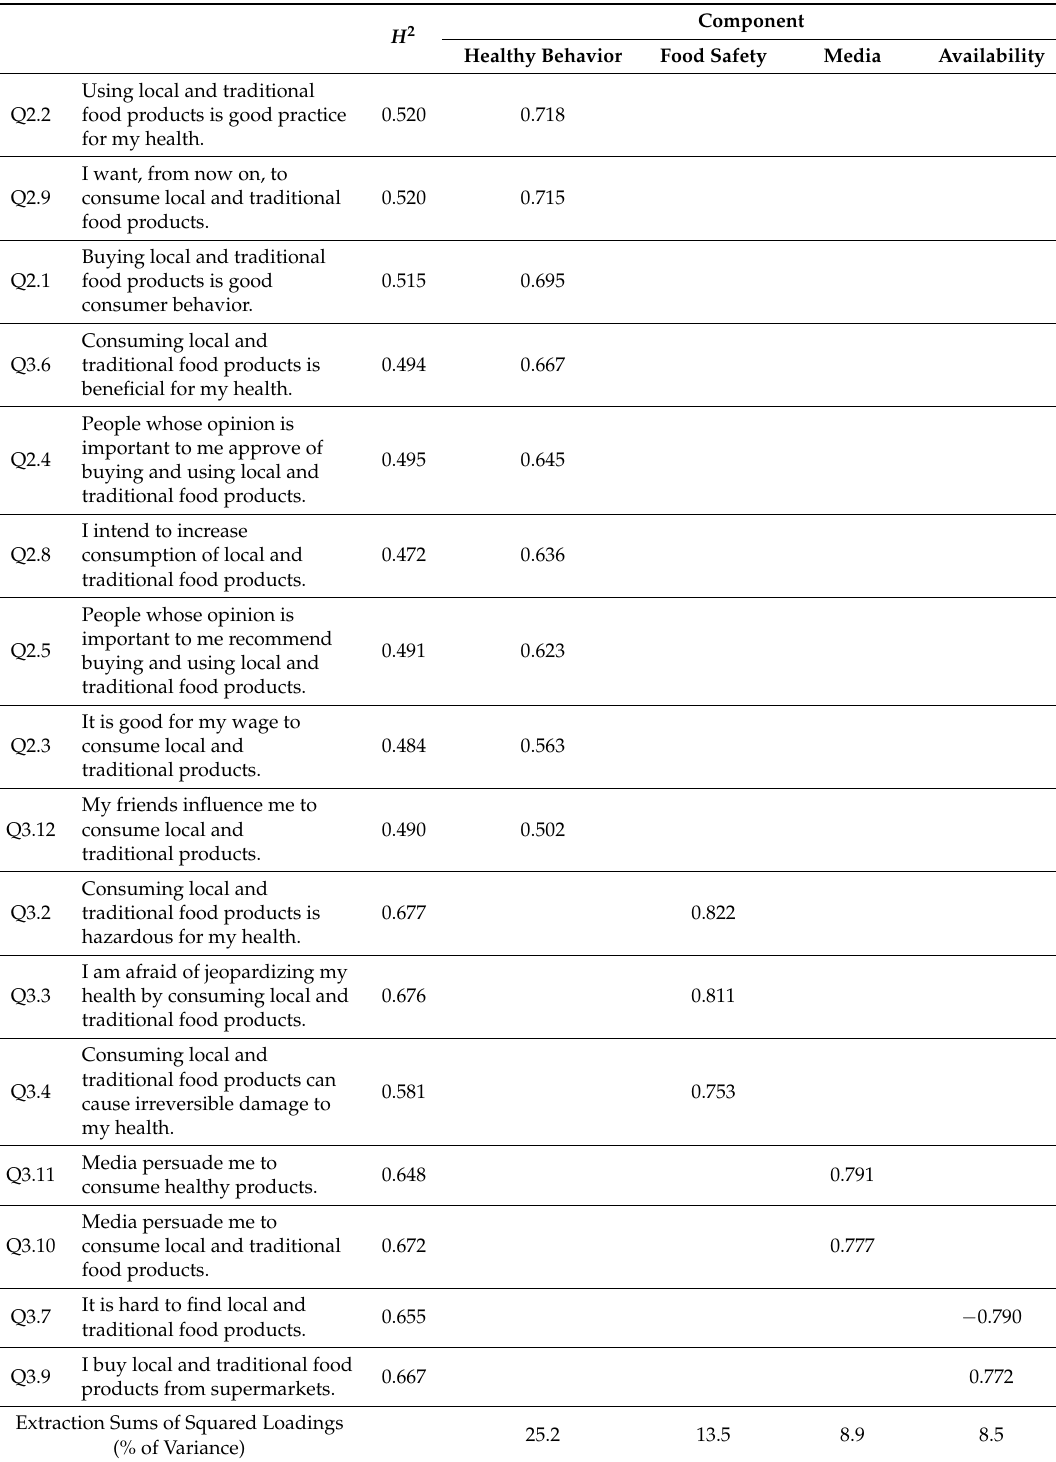
Table 6. PCA results for Subset 2 sample ( n =